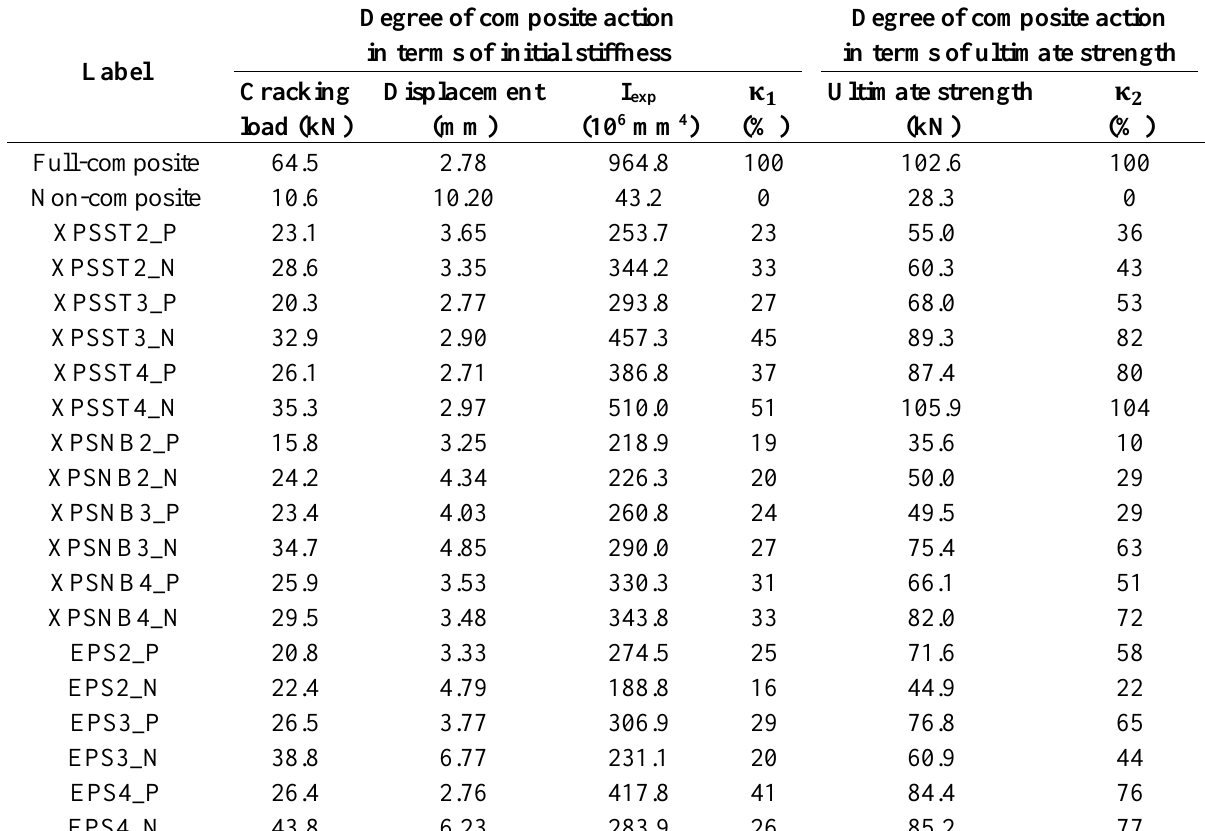
Table 3. Degree of composite action in terms of initial stiffness and ultimate